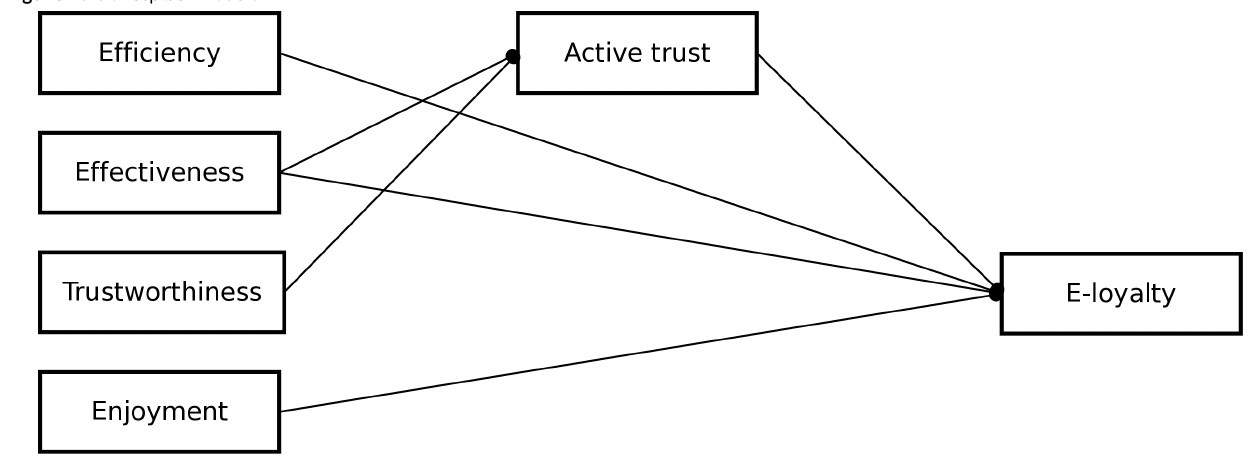
Figure 1. Conceptual